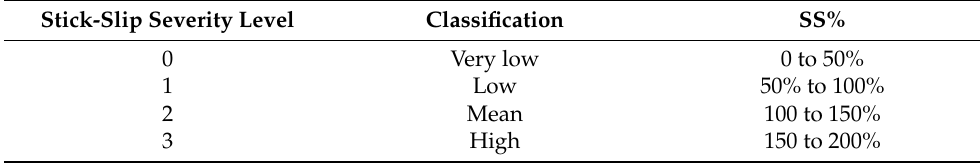
Table 1. Stick-slip severity level classification